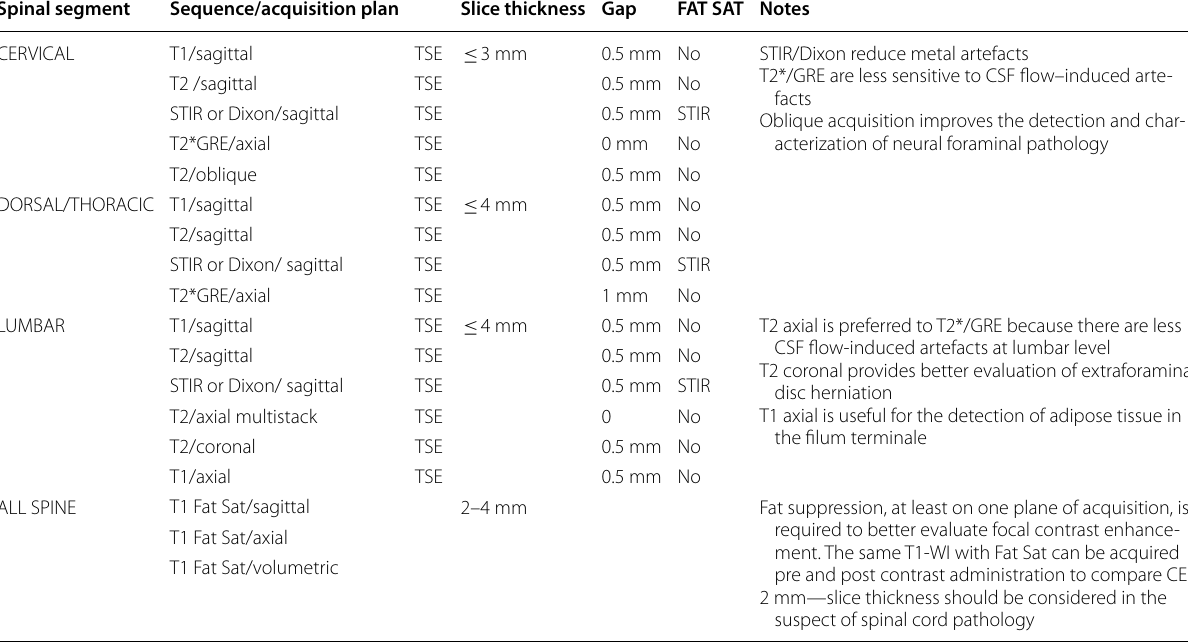
Table 1 Summary of the main acquisition parameters (sequences, slice thicknesses and planes) for the study of the spine as a whole and its specific segments Spinal